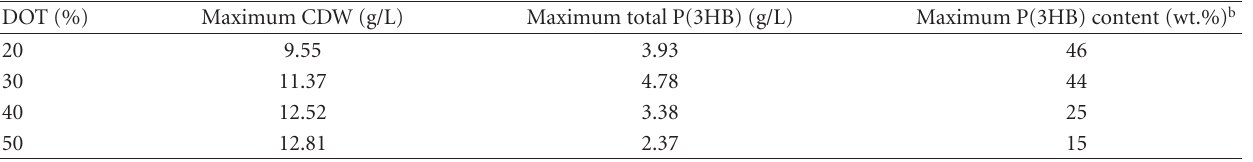
Table 4: E ff ect of DOT (%) level on biosynthesis of P(3HB) a .